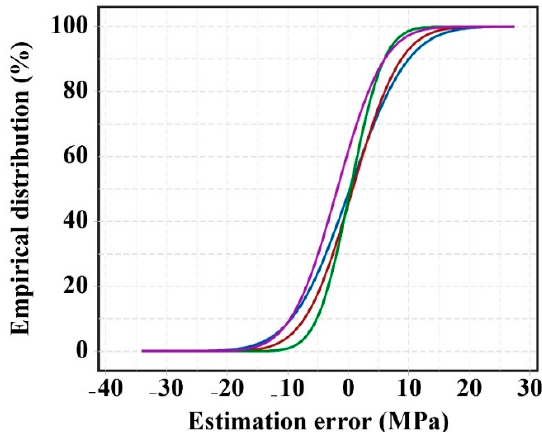
Figure 10. ECDF analysis of developed AI models.